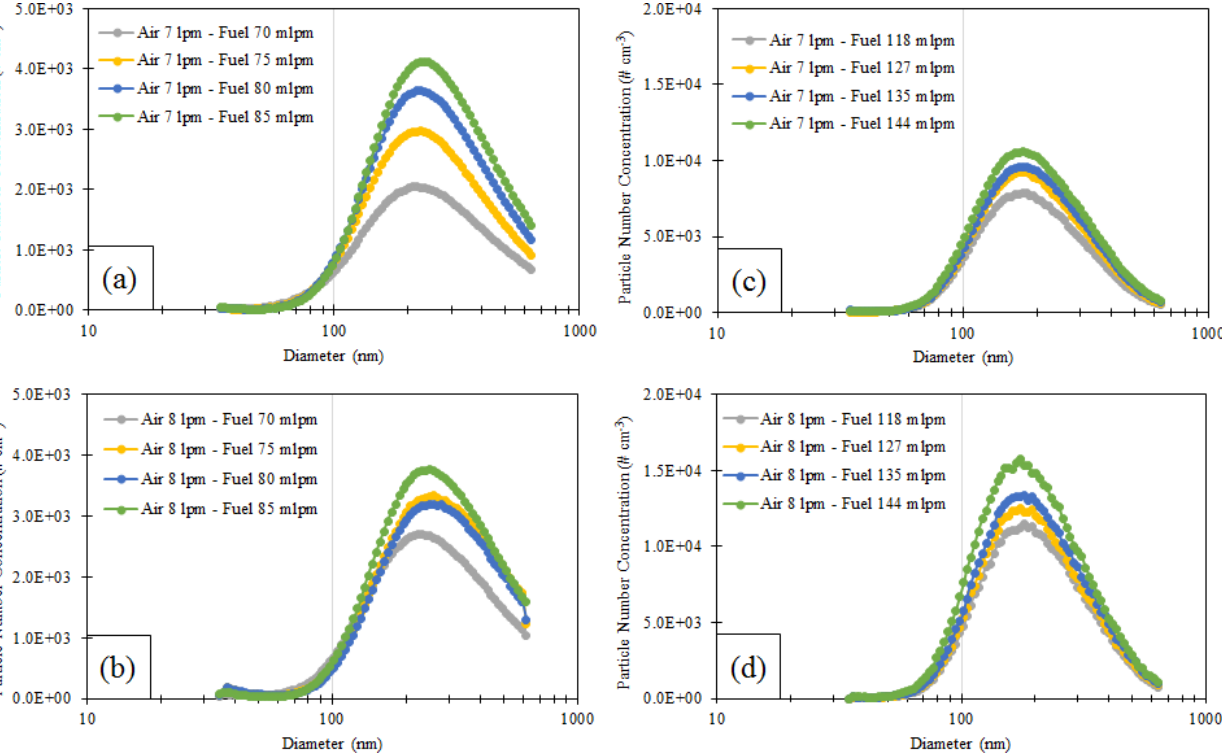
Figure 3. Mean size distributions measured by SMPS. MISG was fuelled with propane (a, b) and ethylene (c, d) , with the air and fuel flows indicated in the frame of the plots.